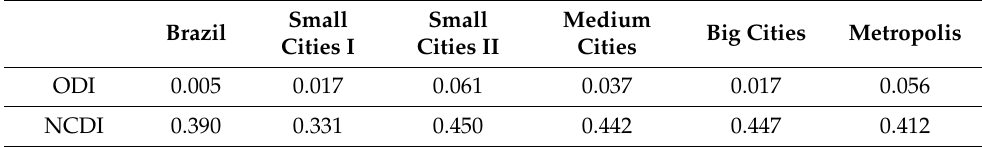
Table 3. ODI and NCDI values for homicide between 2016 and 2017 for Brazil and for city size categories.